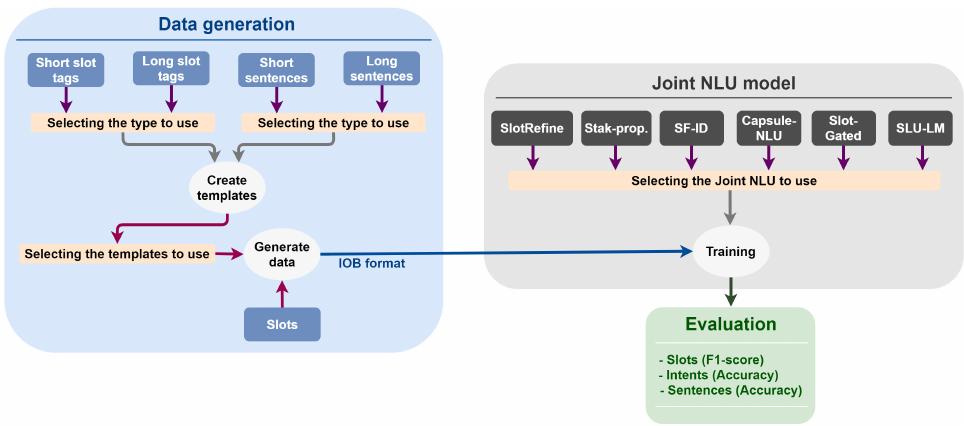
Figure 1. Overview of the